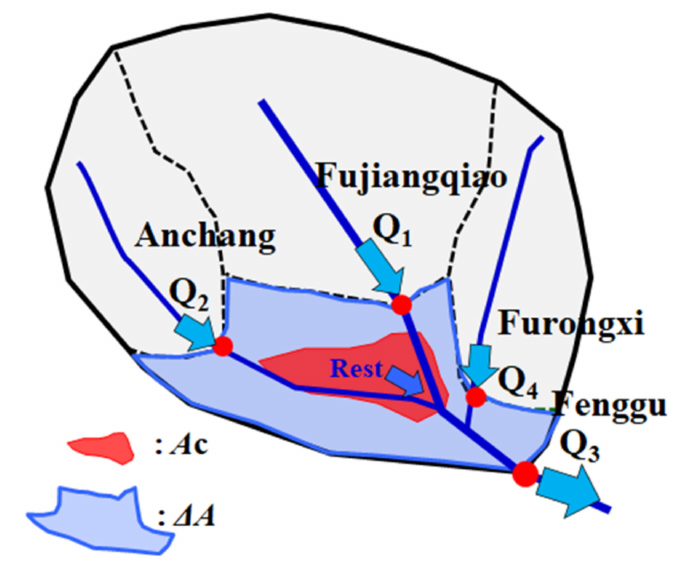
Figure 3. Schematics of water balance analysis